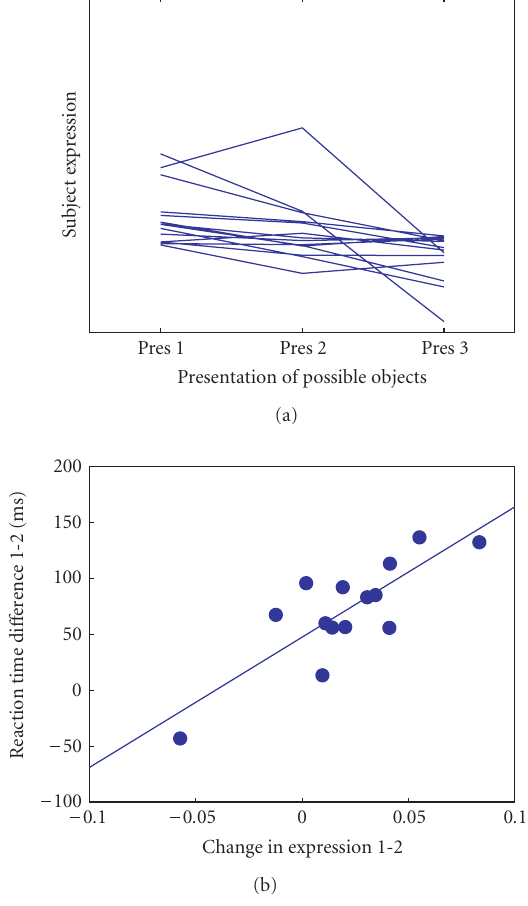
Figure 2: Results of an OrT guided PCA applied to the imaging data of 14 participants in the IP-OD study, for which negative ordi- nal trends were predicted across repeated object presentations (pre- sentation number). A linear combination of the first two principal components (PCs) produced significant results: (a) negative mono- tonic trends exhibited by 12 of 14 subjects in the plot of presenta- tion number versus pattern expression ( p < 0 . 01); and (b) positive correlation ( p < 0 . 0005) between the change score in OrT pattern expression (di ff erence between first- and second-object presenta- tions), and the corresponding change score in reaction time (index of perceptual repetition